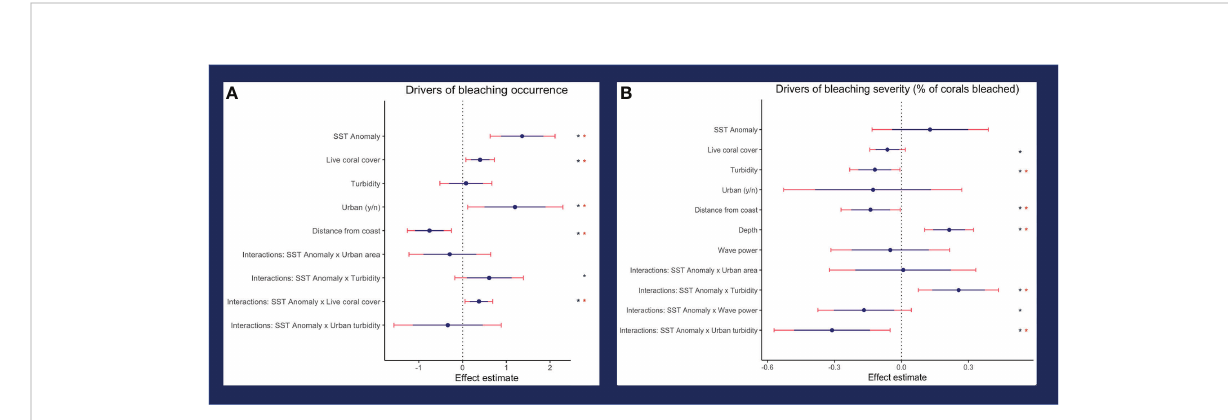
FIGURE 4 Effect of independent variables on (A) bleaching occurrence (binary variable for whether bleaching is present or absent) and (B) bleaching severity (% bleaching cover where bleaching is nonzero). Thin, pink lines show the 95% credible interval, and thick, blue lines show the 80% credible interval. One asterisk indicates signi fi cant variables (80% interval does not cross zero) and two asterisks indicate highly signi fi cant variables (95% interval does not cross